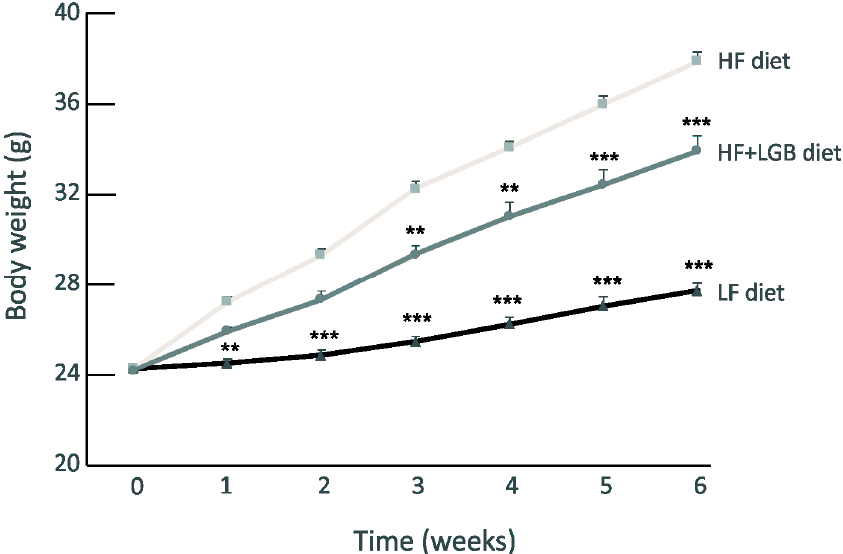
Figure 1. Body weight gain of the mice during the study. Animals received low-fat diet (LF diet, black line), high-fat diet (HF diet, light grey line) or high-fat diet supplemented with lingonberry (HF + LGB diet, grey line). Weight was measured once a week. The results are expressed as grams (g). Values represent mean + SEM, n = 9 mice per group. Two-way ANOVA with Bonferroni post-test was used in the statistical analysis. Mean values significantly different from the high-fat group (HF diet) are marked with ** = p < 0.01 and *** = p < 0.001.